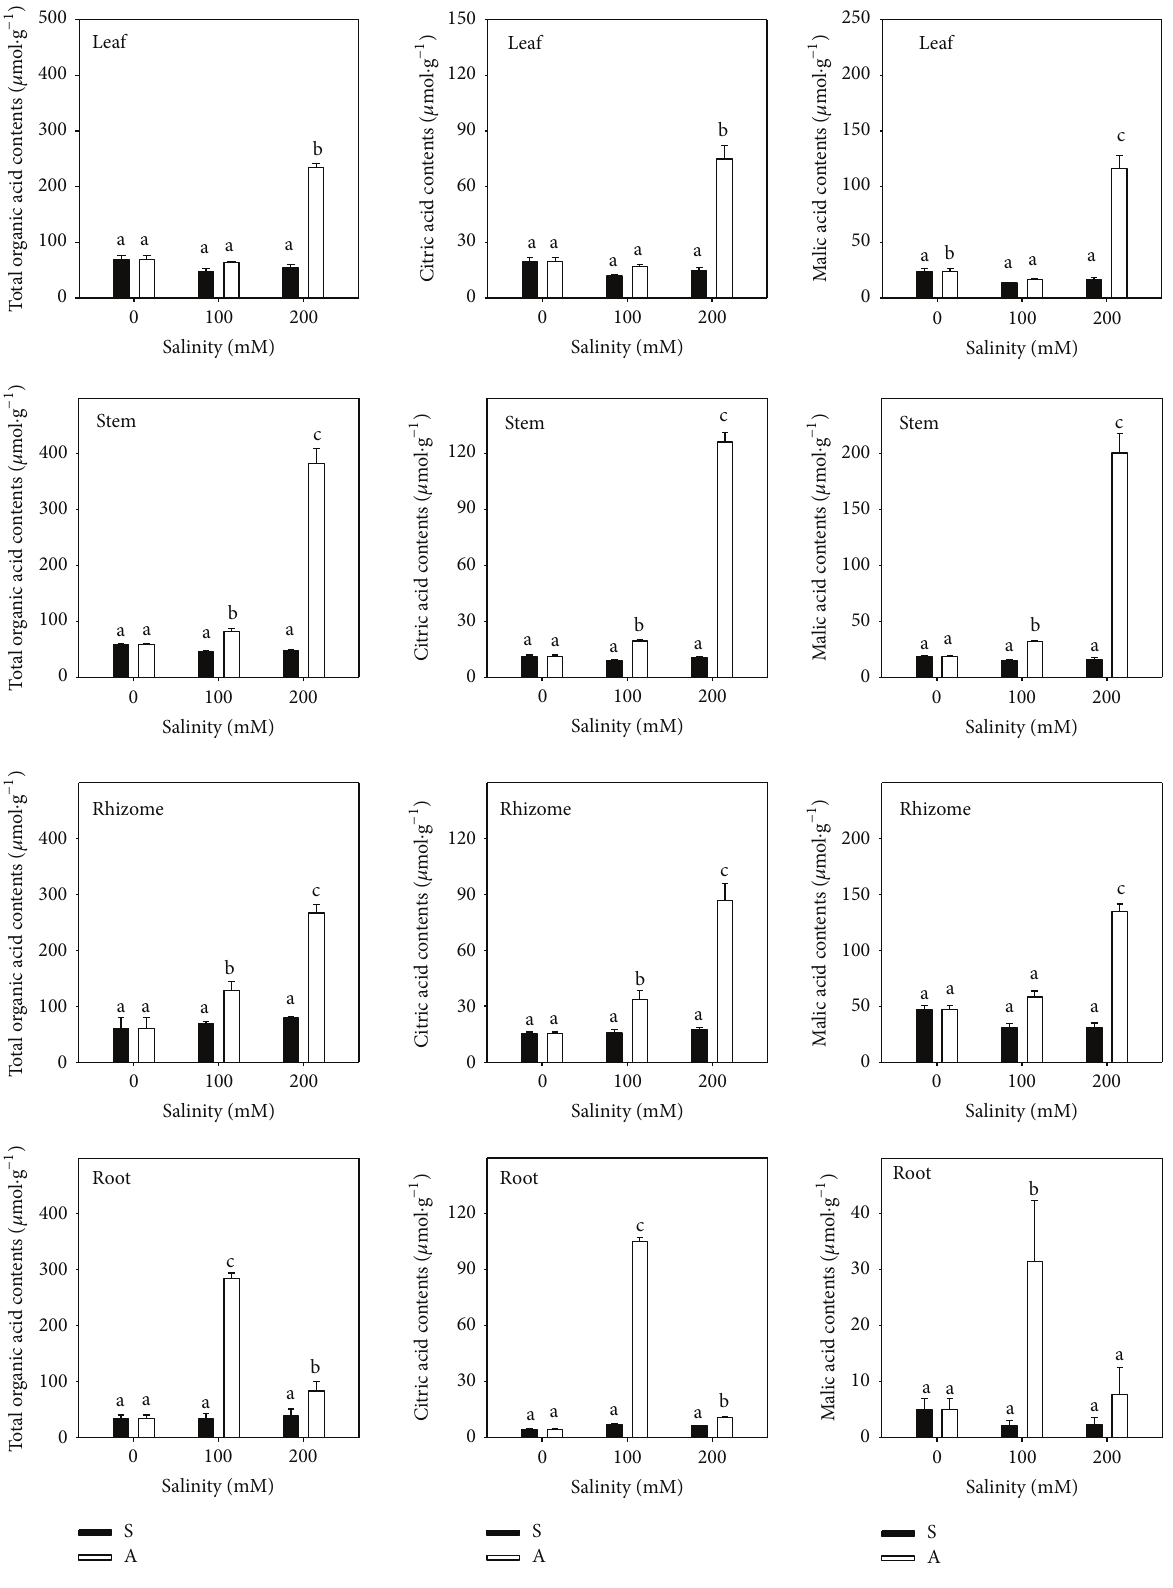
Figure 7: The generous organic acids content. The effect of salt stress (S) and alkali stress (A) on total organic acids, citric acid, and malic acid contents in rhizomes, stems, roots, and leaves of L. chinensis . There are three levels under both stresses: 0, 100, and 200mmol/L. The means and standard errors are reported. Within each column, the different letters indicate significant difference among treatments ( 𝑃 < 0.05